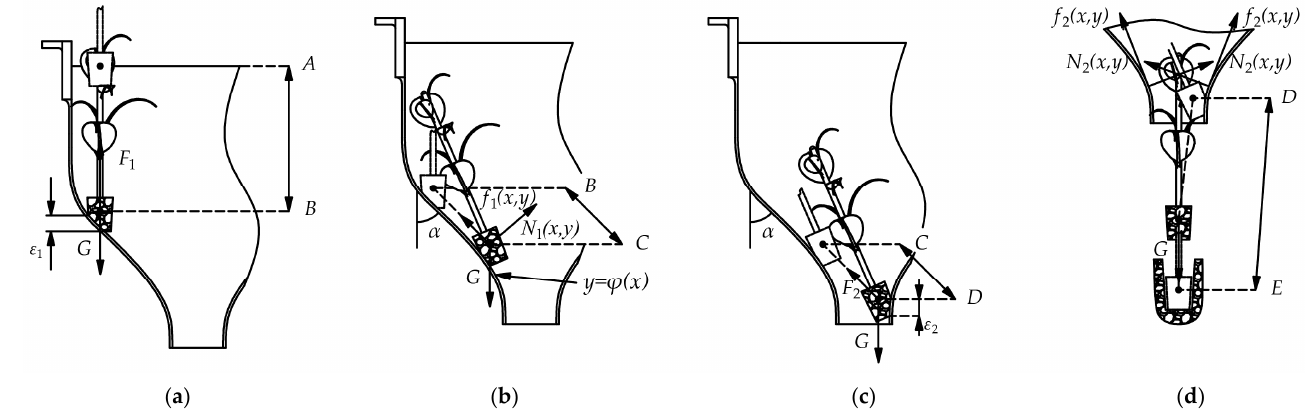
Figure 9. Stage analysis of seedling dropping process in No. 1 position. ( a ) Seedling falling freely from position A to position B. ( b ) Sliding along the inner wall of the seedling cylinder after collision at position B. ( c ) Oblique throwing motion of seedlings after sliding to position C. ( d ) Seedling falls into the planting groove E after a second collision at position